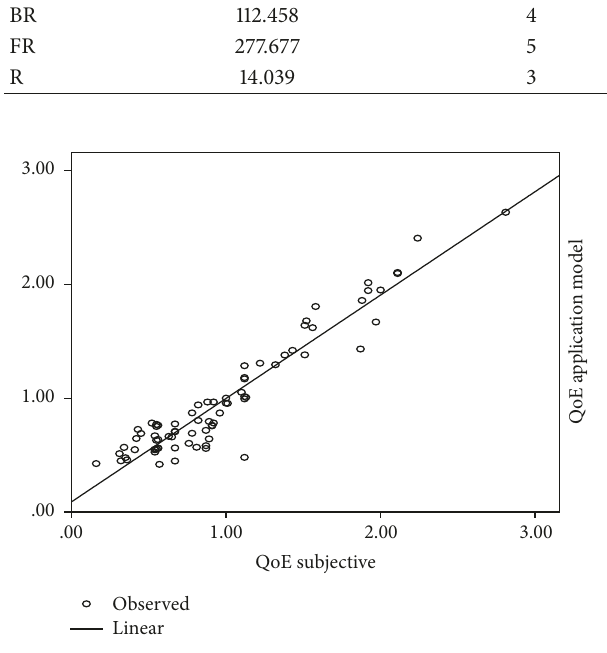
Figure 17: Accuracy of application video model. Table 22: Criteria comparison matrix for application factors.